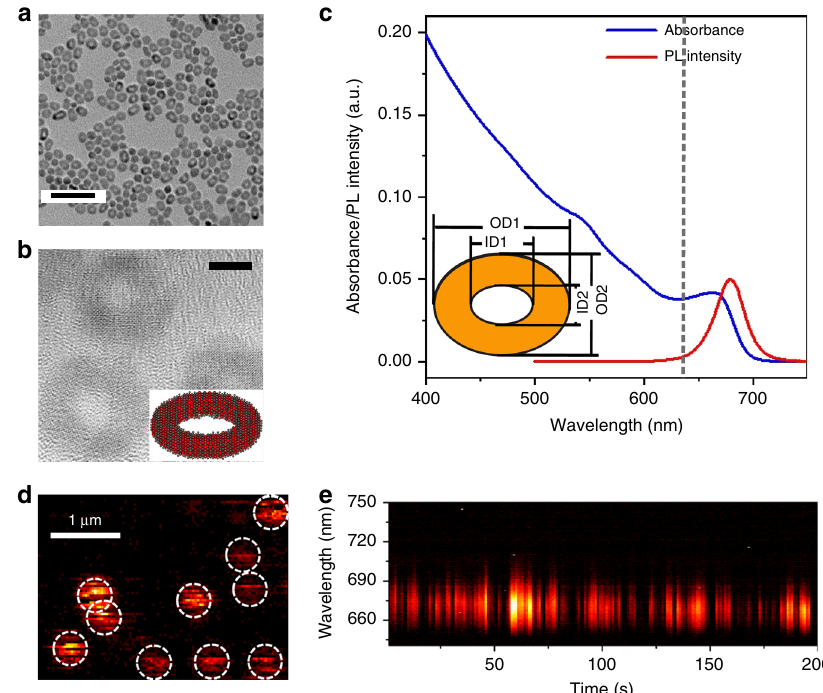
Fig. 1 Ensemble and single particle characterization of CdSe quantum rings. a , b TEM images of the CdSe QRs. Scale bars in a and b represent 50 nm and 5 nm, respectively. c Absorption and emission spectra of CdSe QR ensembles. The vertical dashed line indicates the excitation wavelength for the single particle measurements. The inset is a schematic of the ring geometry. d A scanning photoluminescence image of single QRs. Scale bar: 1 µ m. e A representative time-dependent spectral sequence of a single